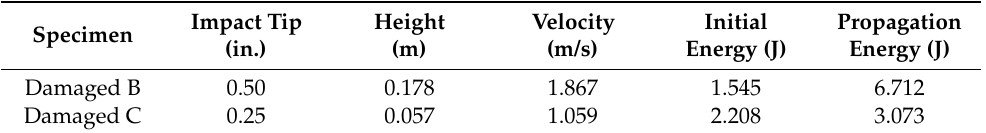
Table 3. Overview of impact loading tests on specimens.